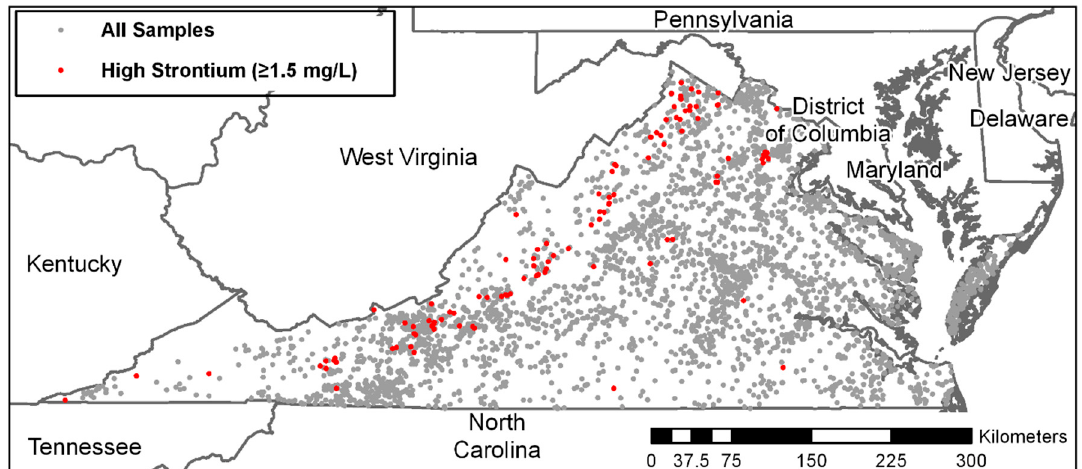
Figure 2. Map of 9779 Virginia Household Water Quality Program (VAHWQP) private drinking 258